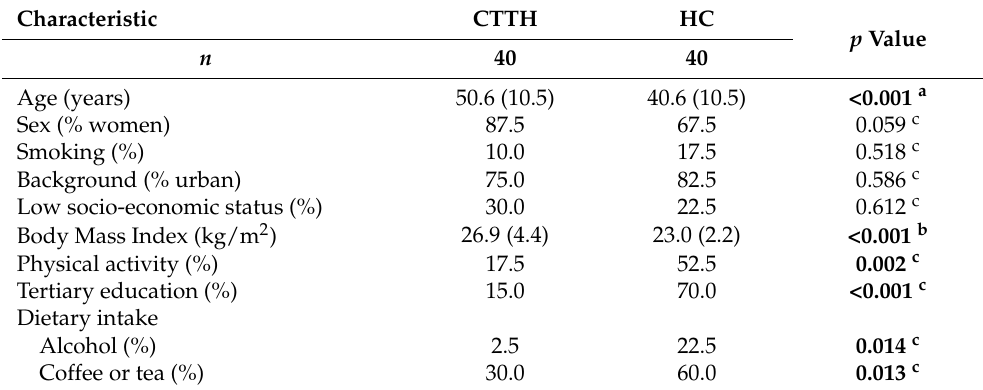
Table 1. Characteristics of CTTH patients and healthy